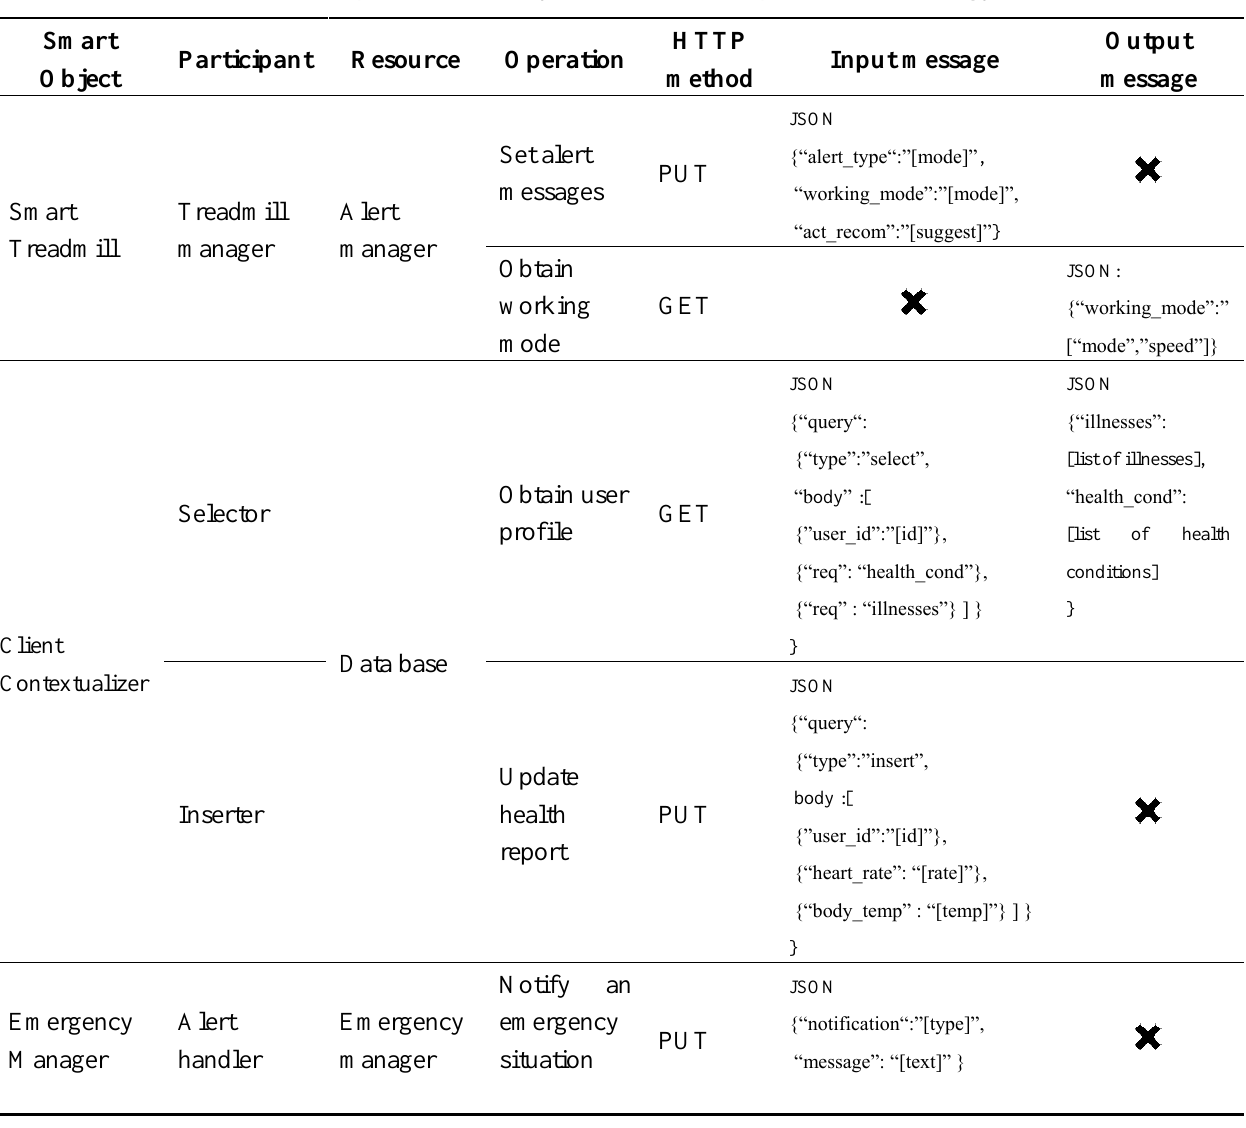
Table 9. Report of the analysis of resource aspect in the smart